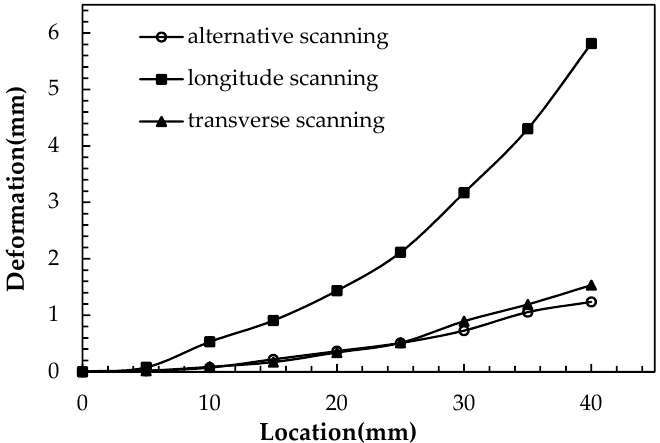
Figure 5. Deformation of the specimens with different scanning routes varying with the x axis.